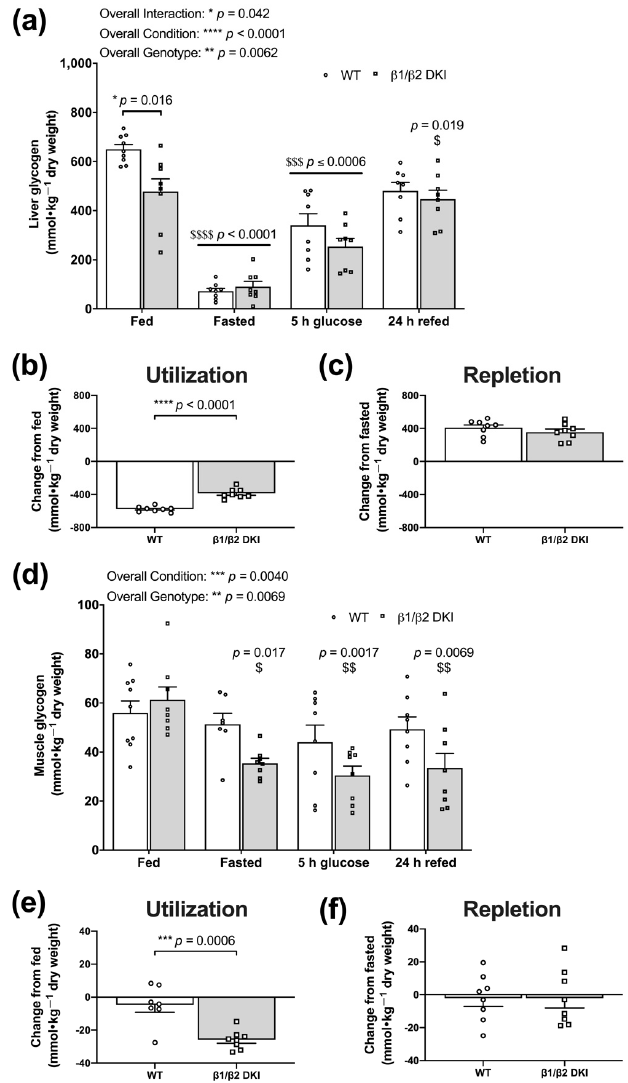
Figure 5. DKI mice display reduced hepatic glycogen concentration in the fed state and increased skeletal muscle glycogen utilization in response to fasting. Liver and skeletal muscle were collected and snap-frozen from male mice in the fed and overnight fasted states, and 5 h- and 24 h-post-administration of a glucose bolus (3.6 g·kg − 1 total body mass) via oral gavage. The 24 h-post-cohort had ad libitum access to chow beginning at 5 h-post-glucose gavage. ( a ) Liver glycogen concentration was assessed in the fed state, overnight fasted state, 5 h-post-glucose gavage, and 24 h-post-glucose gavage and refeeding. ( b ) Utilization was measured as the difference in total glycogen content between fed and overnight fasted conditions. ( c ) Repletion was measured as the difference in total glycogen content between overnight fasted and 24 h-post-glucose gavage and refeeding. ( d ) Fed skeletal muscle glycogen levels were similar between DKI and WT mice but were only significantly reduced in DKI mice following an overnight fast. Glycogen remained suppressed below fed levels at both 5 h-post-glucose gavage and 24 h-post-glucose gavage and refeeding in DKI mice. ( e ) DKI mice had significantly increased utilization of skeletal muscle glycogen compared to WT when subjected to an overnight fast. ( f ) There was no significant glycogen repletion observed in either genotype from the overnight fasted state to 24 h-post-glucose gavage and refeeding. Due to the large number of mice needed for these experiments, a larger range of mouse ages (20–32 wk) was used, n = 7–9. Brackets represent comparison between genotypes within a condition and horizontal bars represent comparison with the fed condition for both genotypes. $ p < 0.05, $$ p < 0.01, $$$ p < 0.001, $$$$ p < 0.0001 versus fed condition from same genotype; * p < 0.05, ** p < 0.01, *** p < 0.001, **** p <